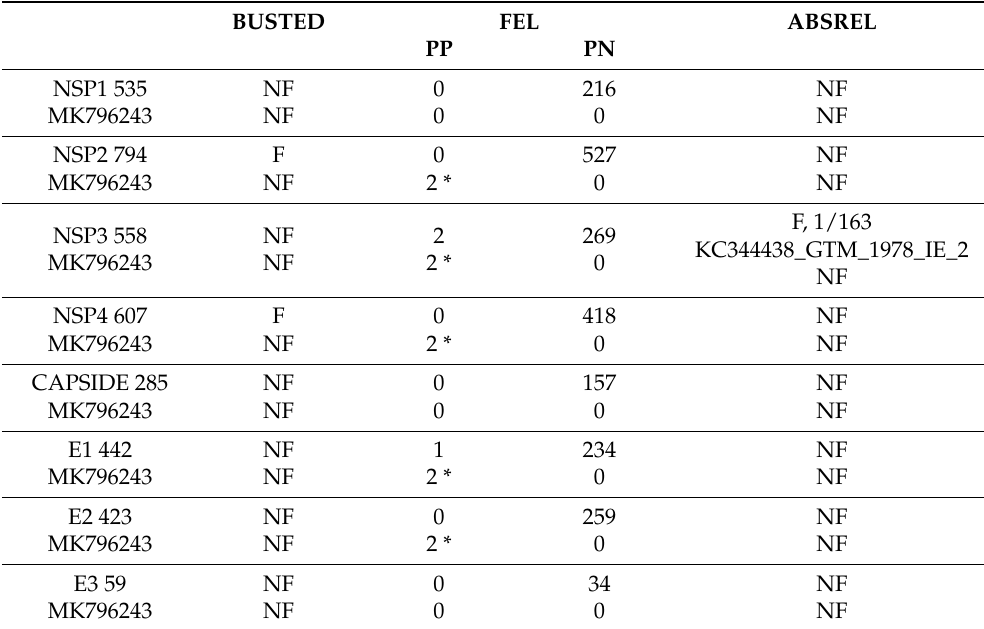
Table 1. Positive selection by gene, branch, and site was obtained with three different methods.